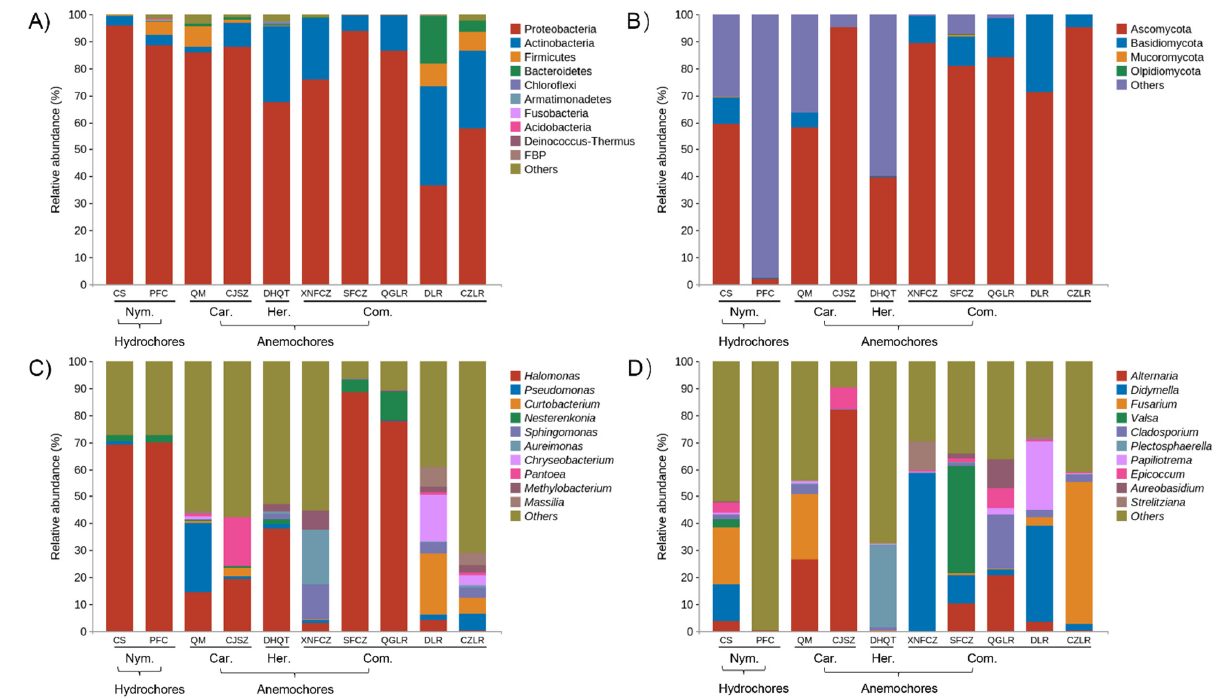
Figure 2. Abundant endophytic bacterial ( A , C ) and fungal ( B , D ) taxa found in the seeds of eight anemochores and two hydrochores. Relative abundance of uncultured and unclassified/unidentified taxa are grouped as ‘Others’. Values are the mean of three replicates. Full names of species abbreviations are described in Figure 1, and the abbreviations below the underline indicate the plant family name (Car, Caryophyllaceae; Com, Combretaceae; Her, Hernandiaceae; Nym, Nymphaeaceae) and their assigned dispersal mode (hydrochores/anemochores).